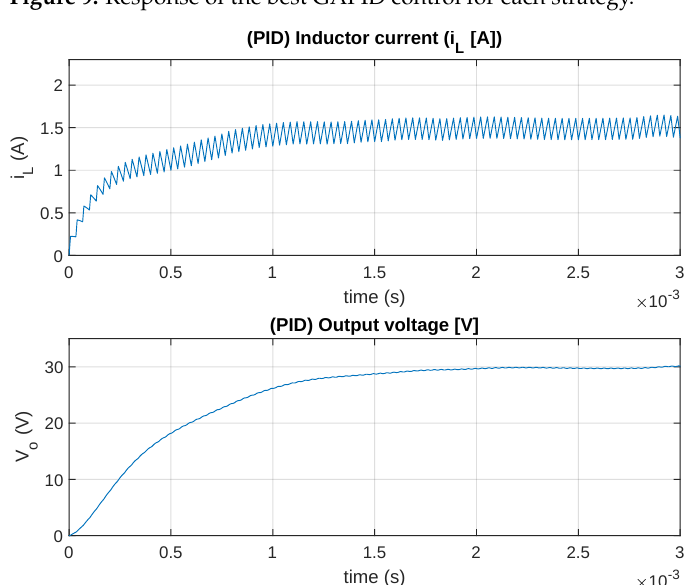
Figure 10. Inductor current i L and output voltage V c under PID control. By analyzing the waveforms, only GAPID optimized by DE 2 presented an overshoot, which was 1.04%, which means the DE resulted in slightly higher gains for GAPID, with a shorter rise time when compared to PSO and GA. In the case of the Buck converter, where the main objective is to generate a regulated output voltage, it does not pose a problem, but depending on the target application, this can be undesirable behavior. The responses of GAPID optimized by PSO and GA are fast and smooth, without overshoot, with a slight advantage over PSO, which can be seen as the best candidate solution to GAPID if overshoot is not allowable. GAPID optimized by PSO and GA perform quite similarly, but GAPID-DE is considerably distinct. That evidences the multimodal characteristic of the GAPID problem where all these solutions have a similar highest level of